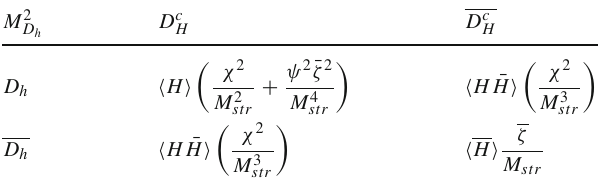
Table 5 The mass matrix for the down-type colour